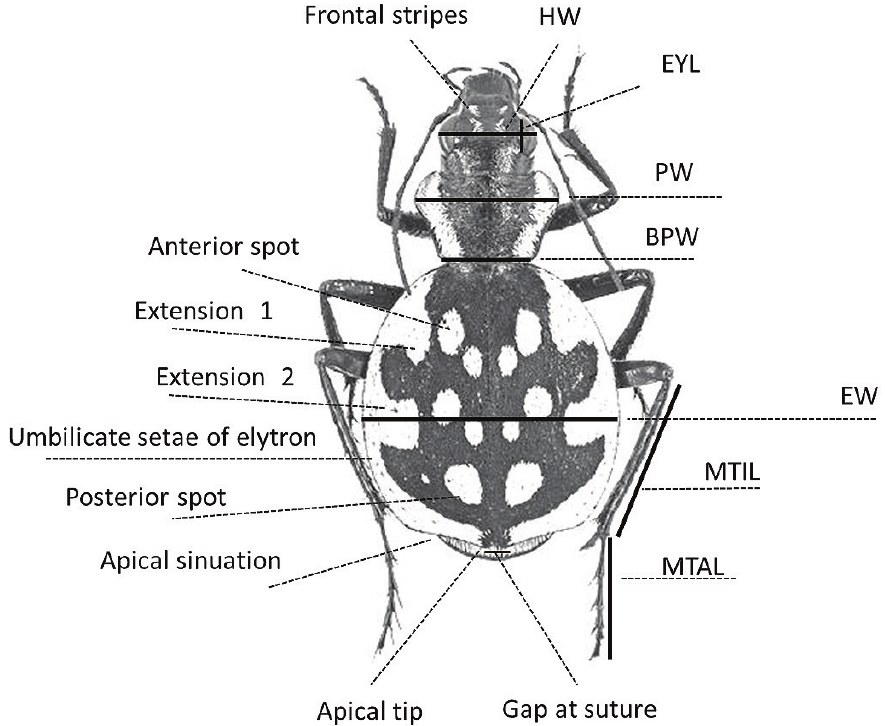
Figure 1. Patterns and morphological characters used in the descriptions ( Graphipterus serrator